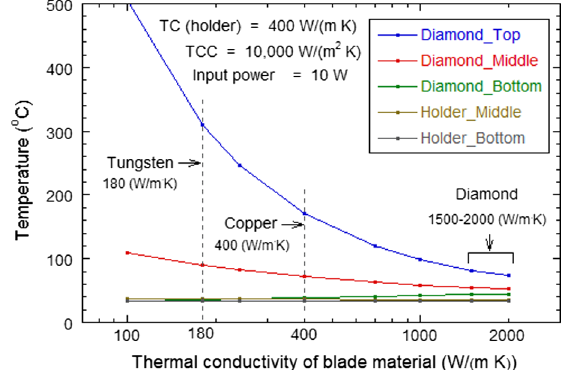
FIG. 10. Temperature variations of the quarter model due to difference in the TCs of blade materials.